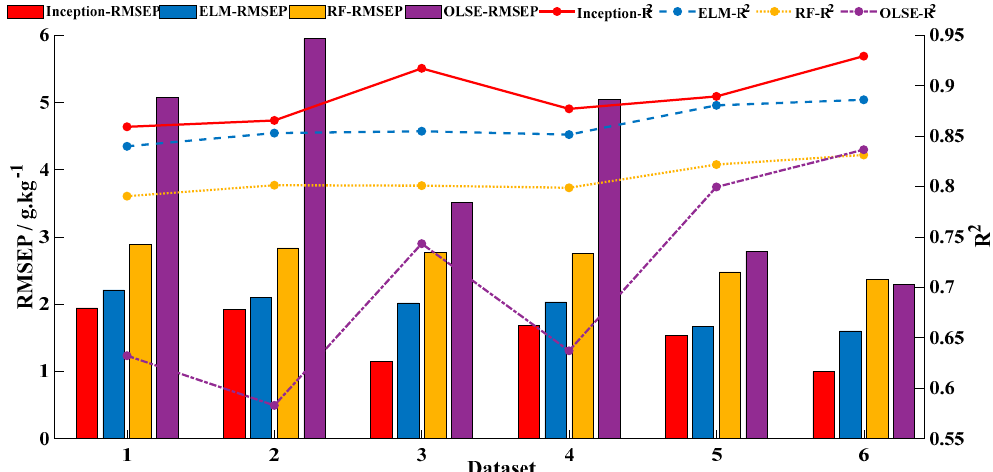
Figure 6. Performance of different predicted models with different size datasets. The models included baseline-corrected OLSE, baseline-corrected RF, baseline-corrected and smoothed ELM, and Model 3 of CNN. (For interpretation of the references to color in this figure legend, the reader is referred to the Web version of this article.).